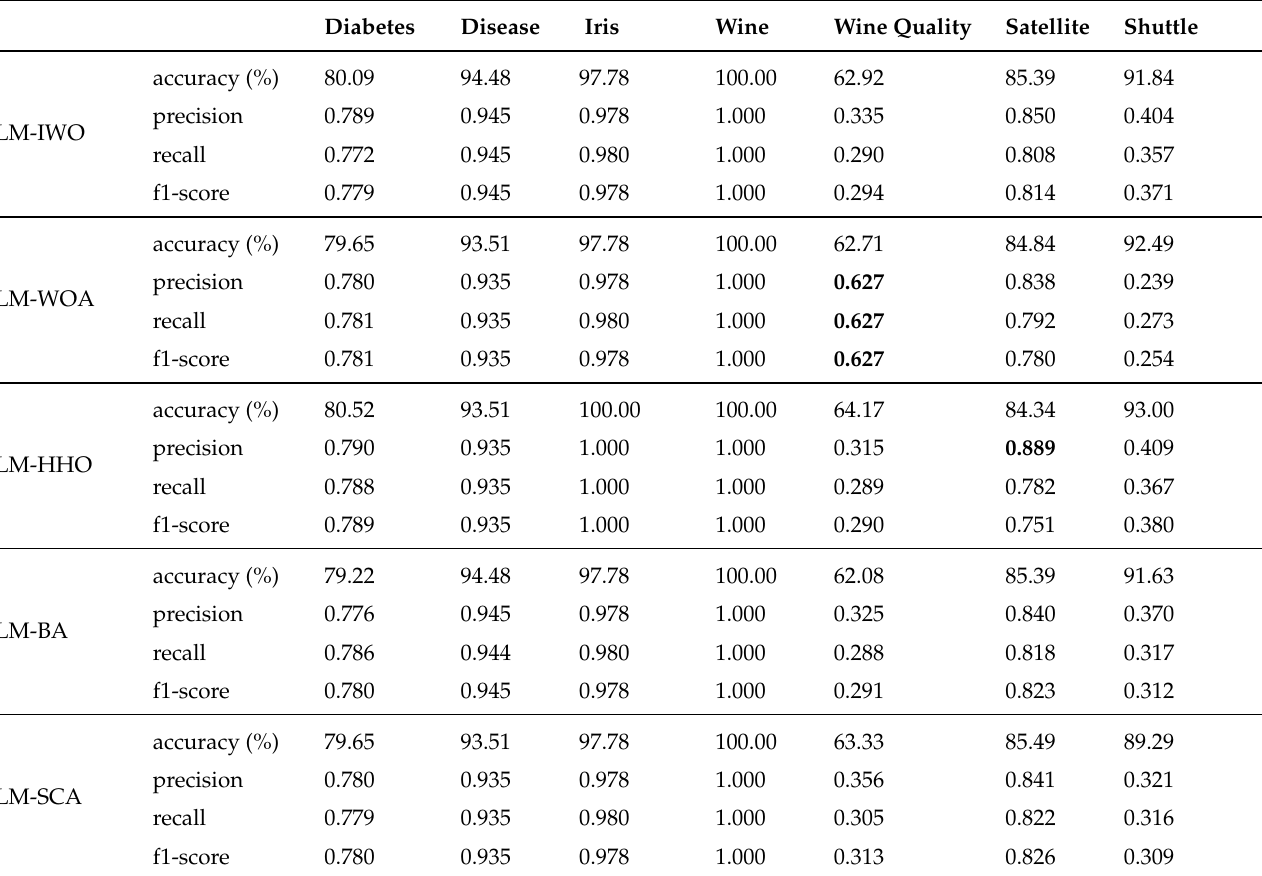
Table 7. Precision, recall and f1-score comparative analysis for simulations with 90 neurons.